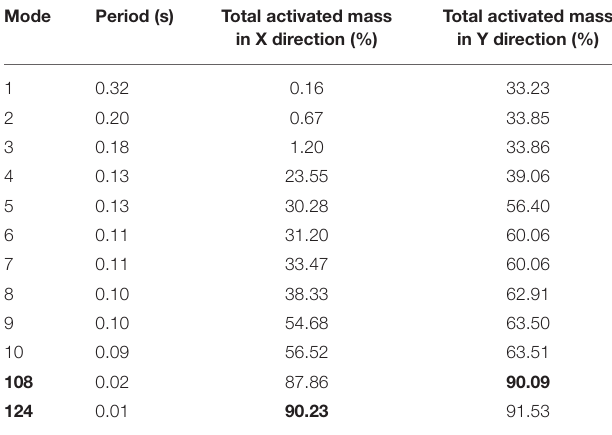
TABLE 2 | Results of modal